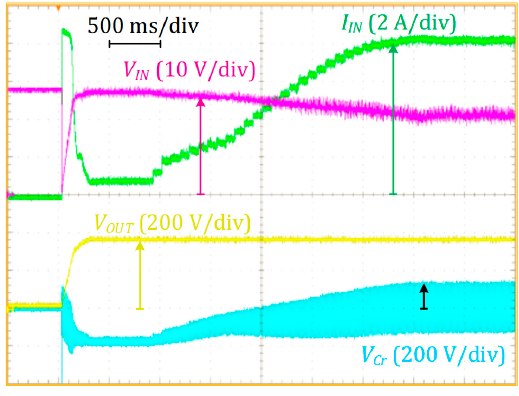
Figure 13. Experimental MPPT